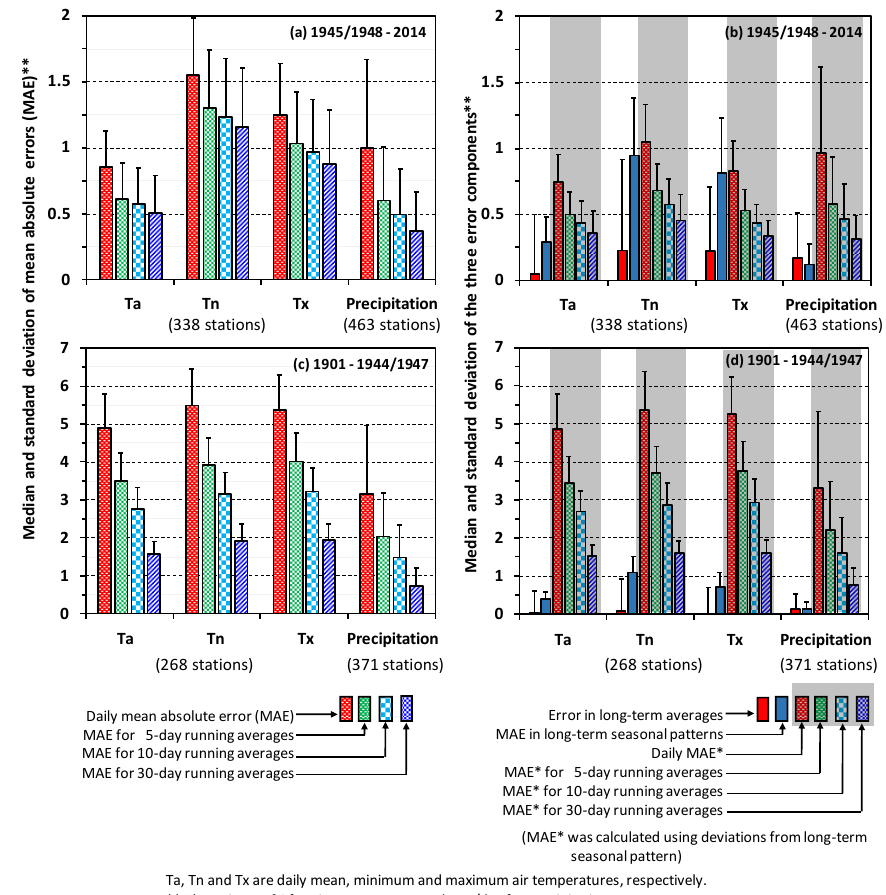
Figure9. TheerrorsofMet1kmcomparingwiththehomogenizeddailyairtemperatureandprecipitation station data for the period from 1945 to 2014 (1948 to 2014 in eastern Canada) and from 1901 to 1944 (1901 to 1947 for eastern Canada). Panels ( a – c ) are for the MAE, and panels ( b , d ) are for the three error components (error in long-term averages (absolute of mean error), MAE in average seasonal patterns, and MAE for the deviations from long-term average seasonal patterns). The large bars and the error bars are for the median and the standard deviations of the errors of all the available climate